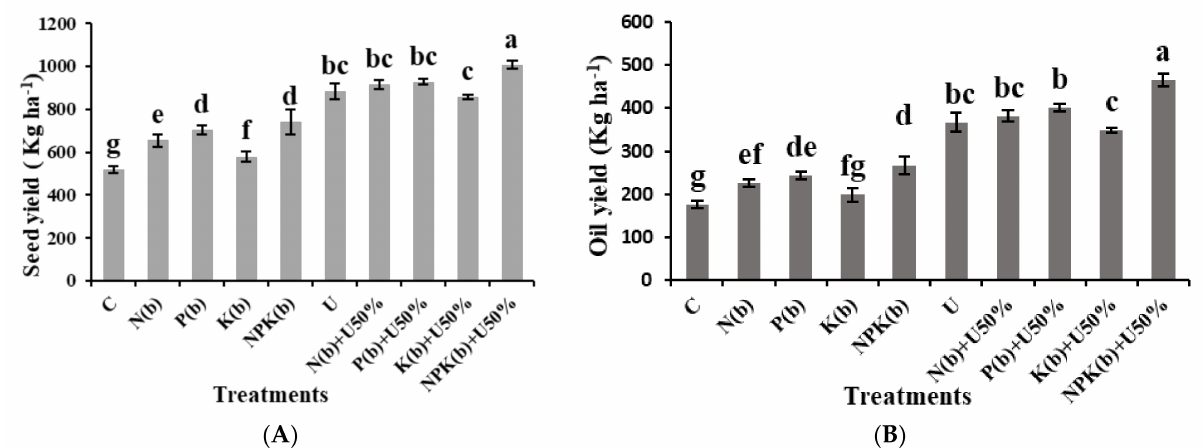
Figure 1. Means comparison for seed yield per hectare ( A ) and oil yield per hectare ( B ) of Nigella sativa L. as influenced by biofertilizers and chemical urea. Different letters indicate a significant difference according to PLSD test with 3 replications at the p ≤ 0.05. (chemical urea fertilizer (U), biofertilizer N (b) , biofertilizer P (b) , biofertilizer K (b) , mixed biofertilizer NPK (b) , 50% urea + biofertilizer N (N (b) + U 50% ), 50% urea + biofertilizer P (P (b) + U 50% ), 50% urea + biofertilizer K (K (b) + U 50% ), and 50% urea + biofertilizer NPK (NPK (b) + U 50%